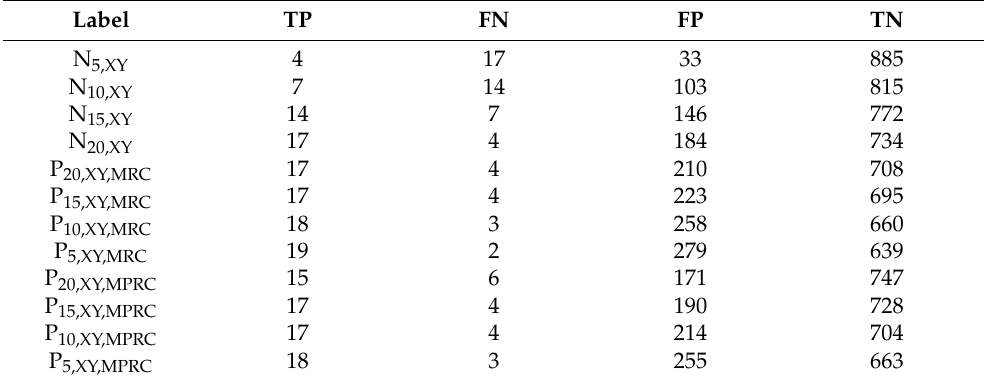
Table 7. Number of elements of the contingency matrix calculated for the rainfall thresholds defined in XY.